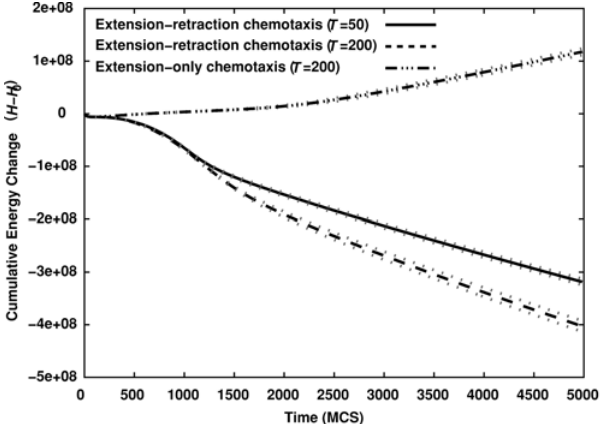
Figure 13. Cumulative energy differences for standard Savill– Hogeweg [ 36 ] extension – retraction chemotaxis (solid and dashed curves, for T =50 and T =200, respectively), and for extension-only chemotaxis (dash-dotted curve, T =200) as a function of time. Black curves show the mean of 100 simulations. Dotted grey curves mark one standard deviation.